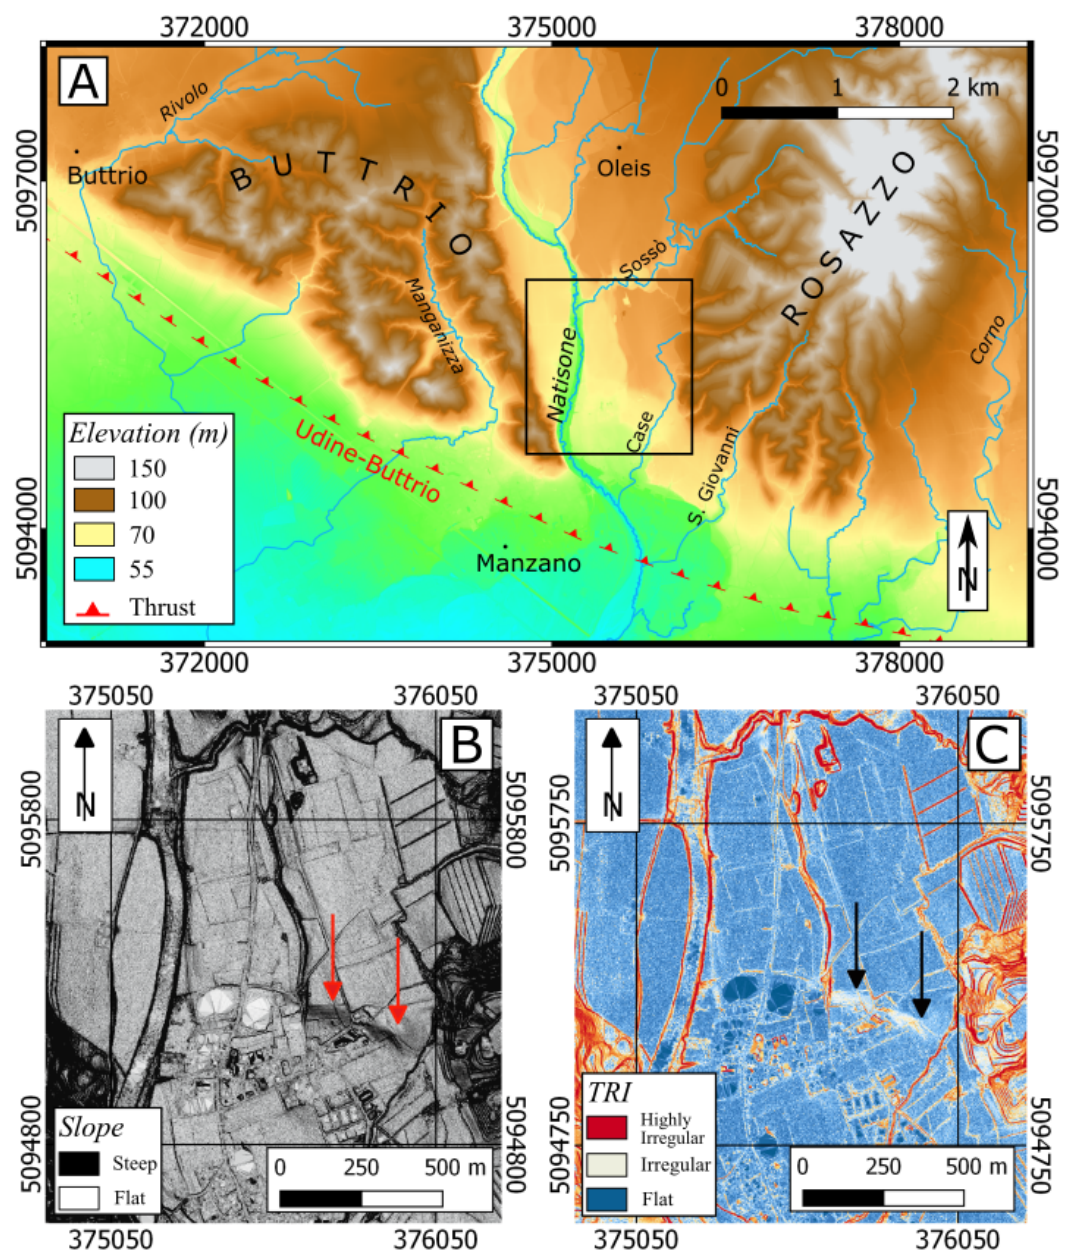
Figure 6. ( A ): Elevation map of the study area encompassing the Buttrio Hill in the west and the Rosazzo Hill in the east. The black rectangle indicates the area shown in panels ( B , C ). ( B ): Slope map calculated from the LiDAR DEM [40]. The red arrows highlight the scarp. ( C ): Terrain ruggedness index (TRI) map calculated from the LiDAR DEM. The black arrows indicate the location of the